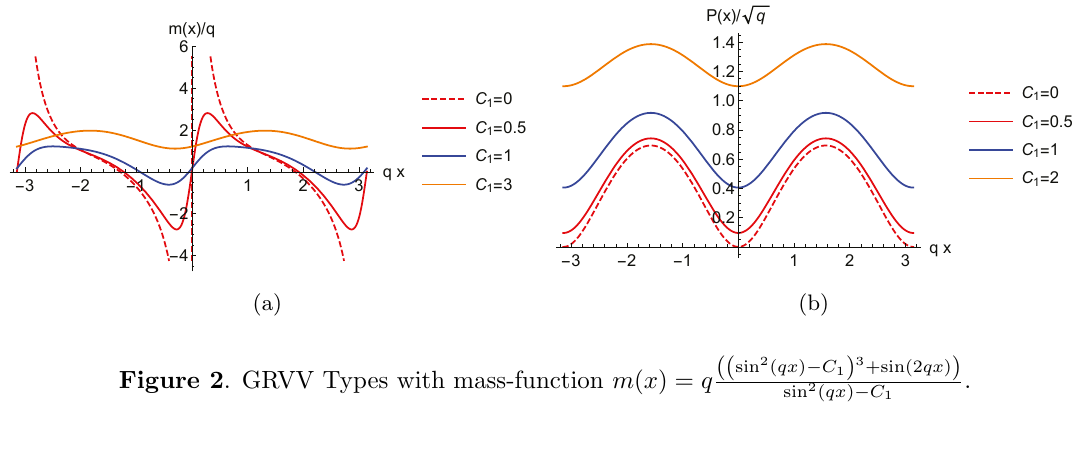
Figure 2 . GRVV Types with mass-function m ( x ) = q